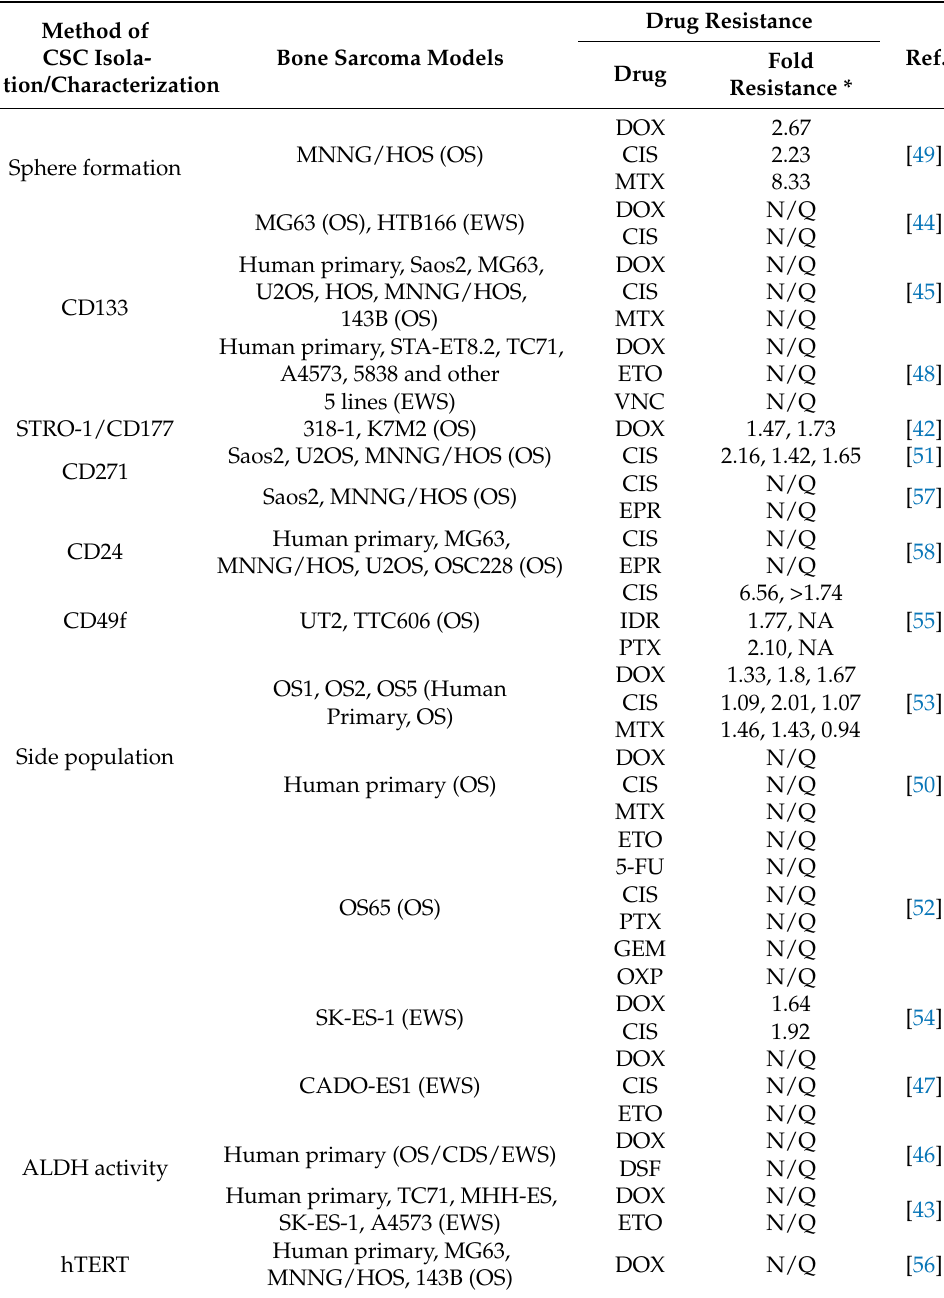
Table 1. Reported drug resistance in bone sarcoma